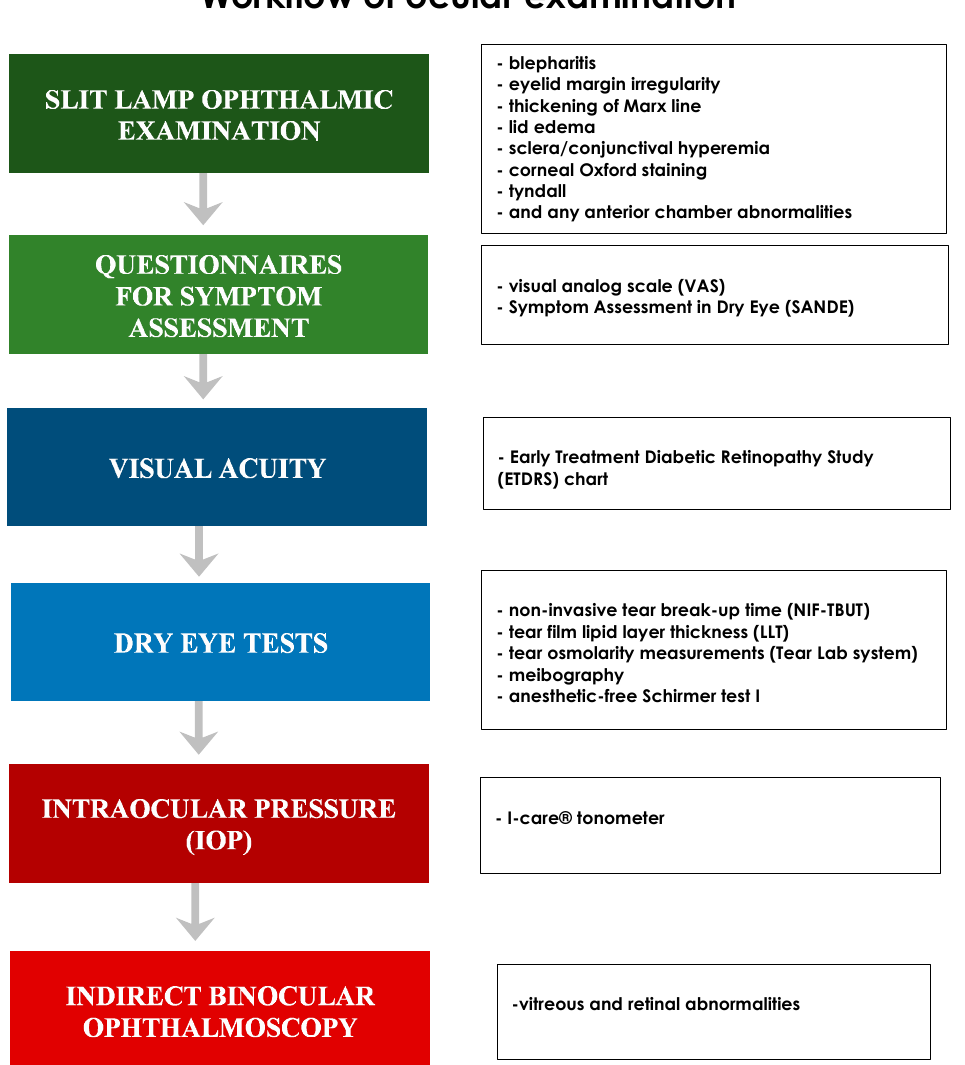
Figure 1. The workflow of the study. The Figure describes the sequence of ophthalmological examination performed in SSc patients enrolled in the study.